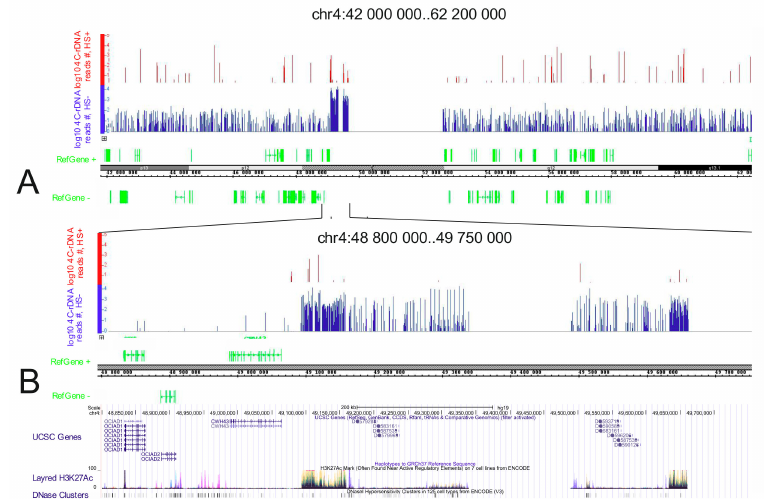
Figure 6. Profiles of 4C-rDNA reads in a fragment of chr4 before (shown in blue) and after (shown in red) heat shock treatment. ( A ) The position of rDNA contacts around the pericentric region of chr4. ( B ) The profiles of rDNA contacts and the distribution of H3K27ac marks in the pericentric region of